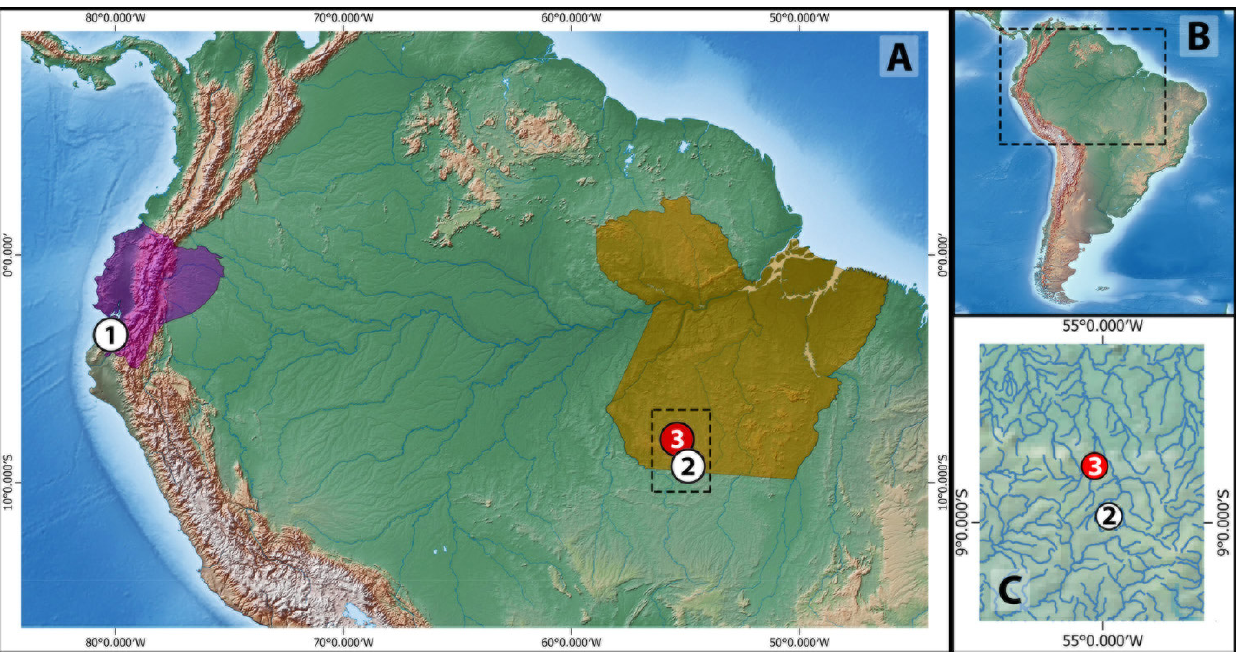
FIGURE 1 | Distribution of Lebiasina species with available cytogenetic data, highlighting the Brazilian state of Pará (orange) and Ecuadorian (purple) territories A . 1. L. bimaculata , 2. L. melanoguttata (Sassi et al. , 2019), and 3. L. minuta (this study). B. Highlights the position of A in South America, and C. indicates that, although close, species 2 and 3 does not share an overlapped distribution.